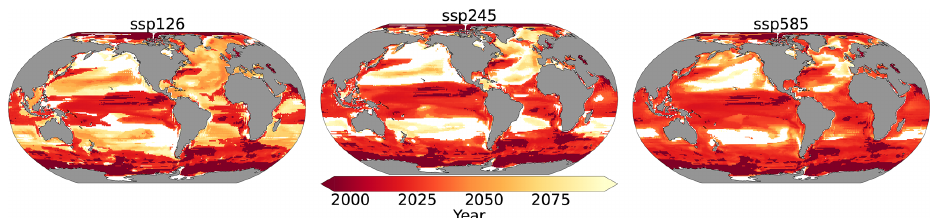
Figure 6. Time of emergence of the multi-model mean anomaly under different scenarios. White regions indicate where the anthropogenic signal cannot be detected even towards the end of the